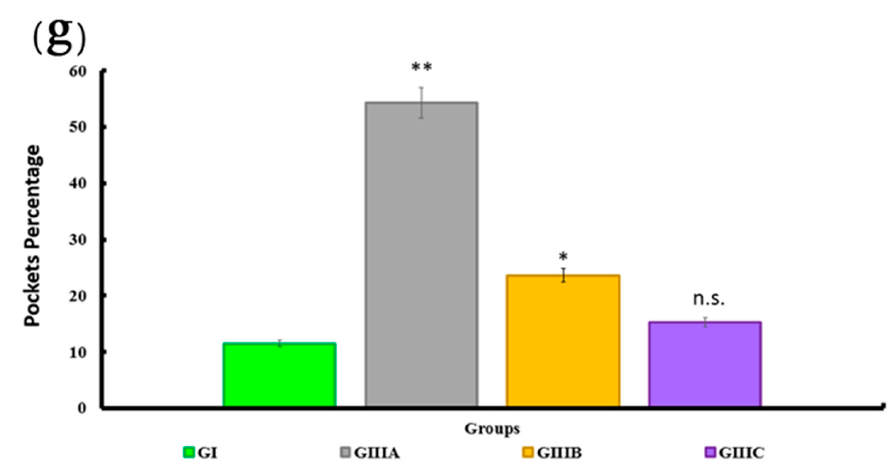
Figure 7. A photomicrograph of control liver, decellularized scaffolds as well as scaffold 4, 14, and 24 days after IPS cell seeding showed ( a ): Microscopic segmentation of hepatic parenchyma, structures such as the hepatic lobules, the central veins (CV), Portal vein (V), hepatic artery (A) and extracellular matrix are present within the parenchyma, x100; ( b ): Ultrastructural characterization of the normal liver matrix showed hepatic plates (*) with the central vein (CV), ×600; ( c ): Ultrastructural characterization of the decellularized scaffold showed rope-like bundles (curved arrow) and filaments of connective tissue fibers forming three-dimensional network arranged in a honeycomb-like structure with hepatocytes pockets (thin arrow), ×600; ( d – f ): Ultrastructural characterization of the recellularized scaffold showed decreased hepatocytes pockets (thin arrow) with increased cellular content (*) with the increased period of seeding, ×600. ( g ): A histogram represents the mean pocket number in all experimental groups. The significant differences against the control group indicated by a * for p < 0.05 and a ** for p < 0.01. n.s.: non-significant. Data are shown as mean ± S.E.M, n =